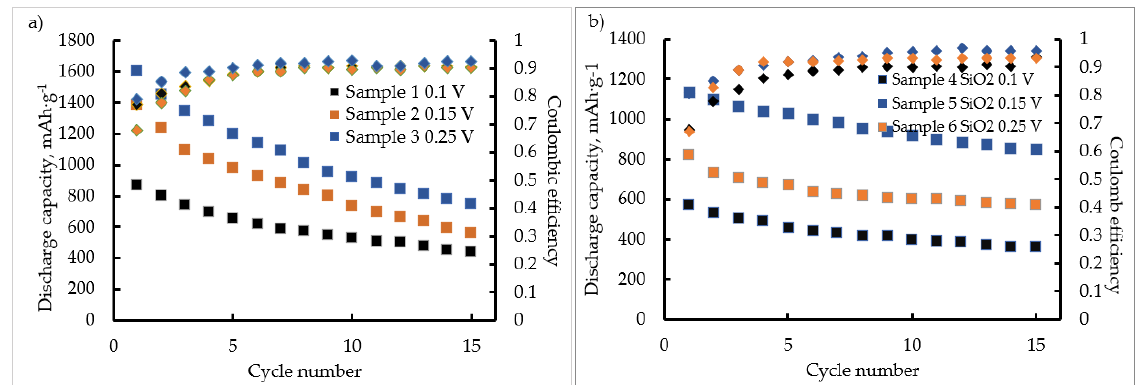
Figure 7. Cycling performance and the coulombic efficiency of the Si/C made from silicon electrodeposited from ( a ) KCl–K 2 SiF 6 (samples 1–3) and ( b ) KCl–K 2 SiF 6 –SiO 2 (samples 4–6) at the cathode overvoltages of –0.1, –0.15, and –0.25 V. Diamonds - с oulombic efficiency; squares - capacity.